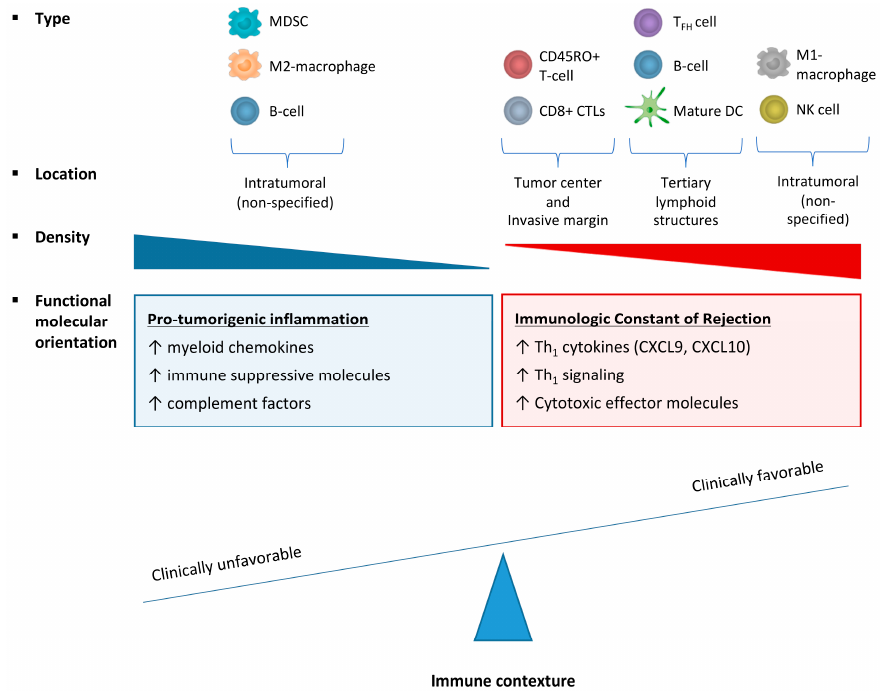
Figure 1. Attributes of an unfavorable versus favorable intratumoral immune contexture. The immune contexture of a tumor is defined by the combination of type, location and density of infiltrating immune cells and functional molecular orientation of the tumor microenvironment. A favorable immune contexture is defined by infiltrating CD45RO + memory T cells, CD8 + cytotoxic T-lymphocytes (CTLs) to the tumor center and invasive margin and infiltration of follicular T-helper cells (T FH ), B-cells and mature dendritic cells (DC) to tertiary lymphoid structures and infiltration of M1-macrophages and NK cells. A favorable functional molecular orientation is characterized by expression of immunologic constant of rejection (ICR) genes, including T-helper type 1 (Th 1 ) cytokines (e.g., Chemokine (C-X-C motif) ligand 9 (CXCL9), and -10 (CXCL10)), Th 1 signaling and cytotoxic effector molecules. An unfavorable immune contexture in terms of patient prognosis is characterized by intratumoral myeloid derived suppressor cells (MDSC), M2-macrophages and B-cells associated with pro-inflammatory gene expression, including myeloid chemokines, immune suppressive molecules and complement factors.